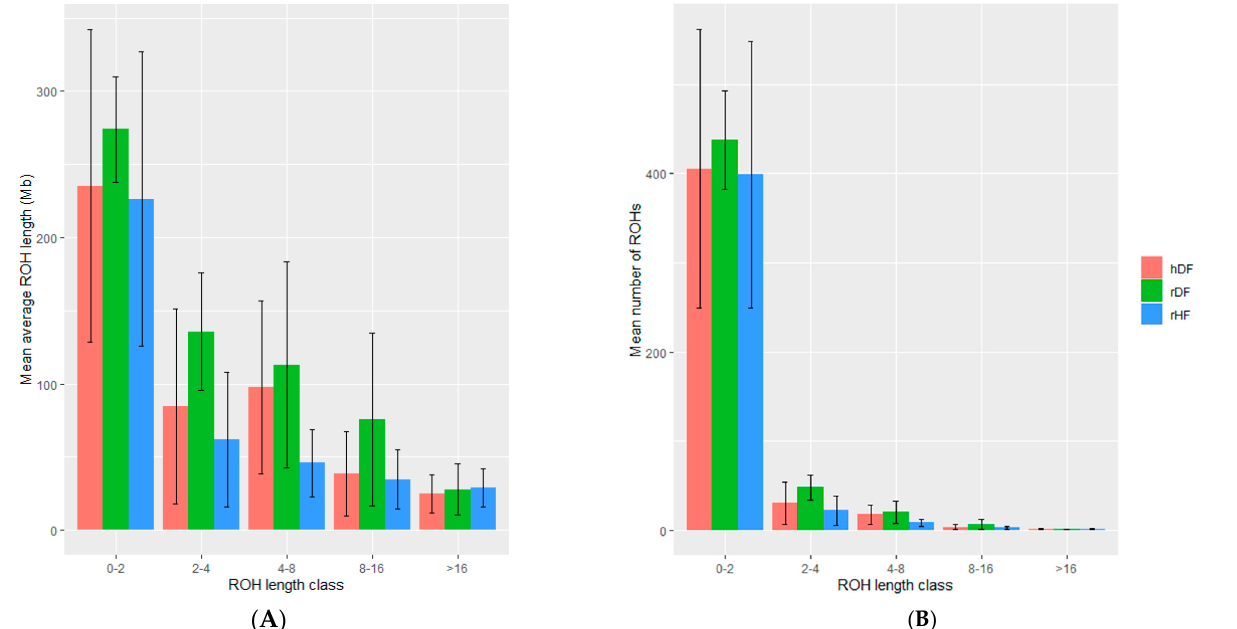
Figure 3. The mean and standard deviation of the average length of runs of homozygosity (ROH) ( A ) and mean number of ROH within each ROH length class ( B ).